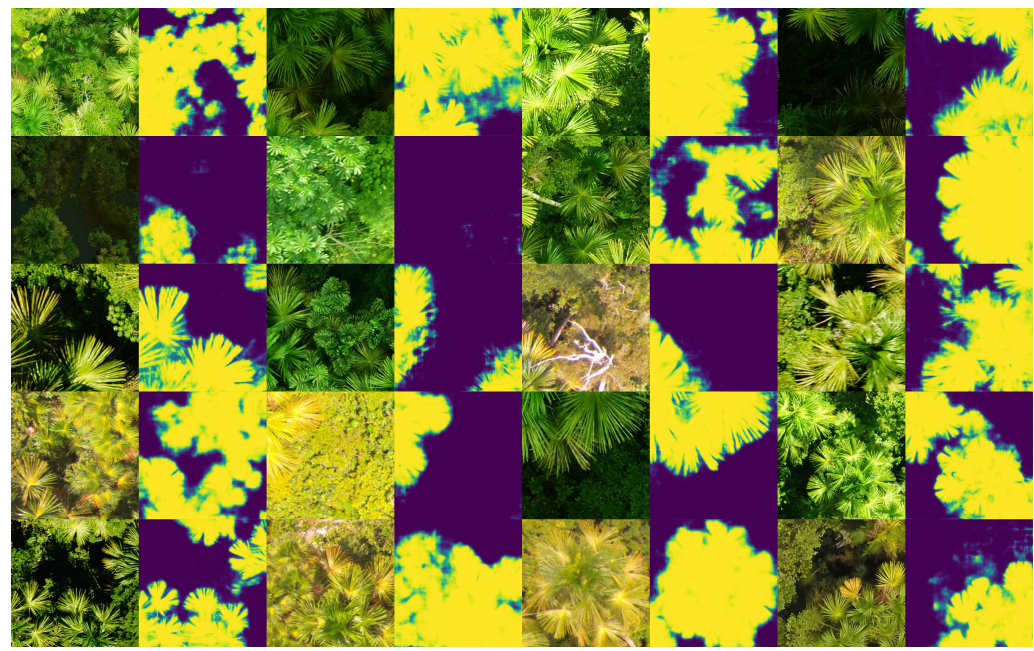
Figure 10. Mauritia flexuosa segmentation